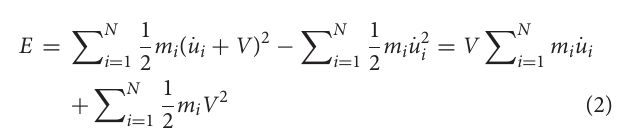
Frontiers in Built Environment |